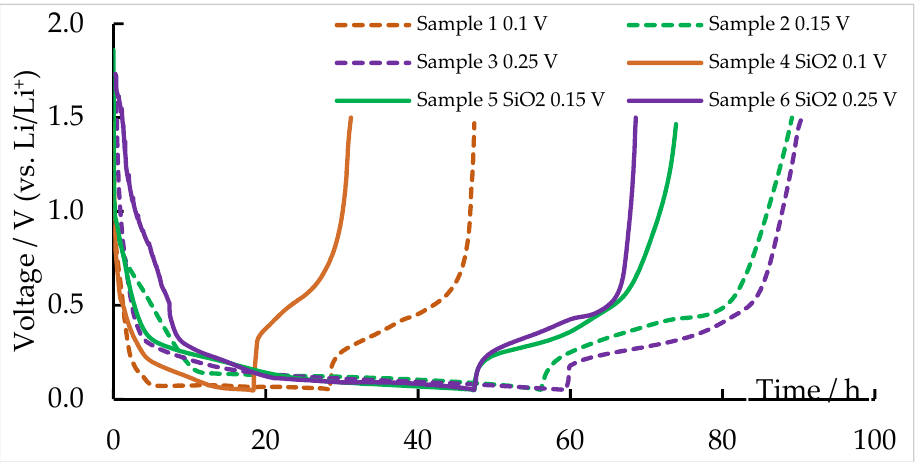
Figure 6. First charge/discharge cycle curves of Si/C composites based on electrodeposited silicon at 50 mA g − 1 . Solid lines represent silicon deposited from molten KCl–K 2 SiF 6 ; dashed lines represent silicon deposited from molten KCl–K 2 SiF 6 –SiO 2.